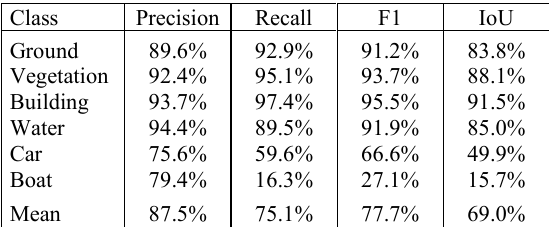
SUM benchmark dataset. Per - class results of point cloud classification.